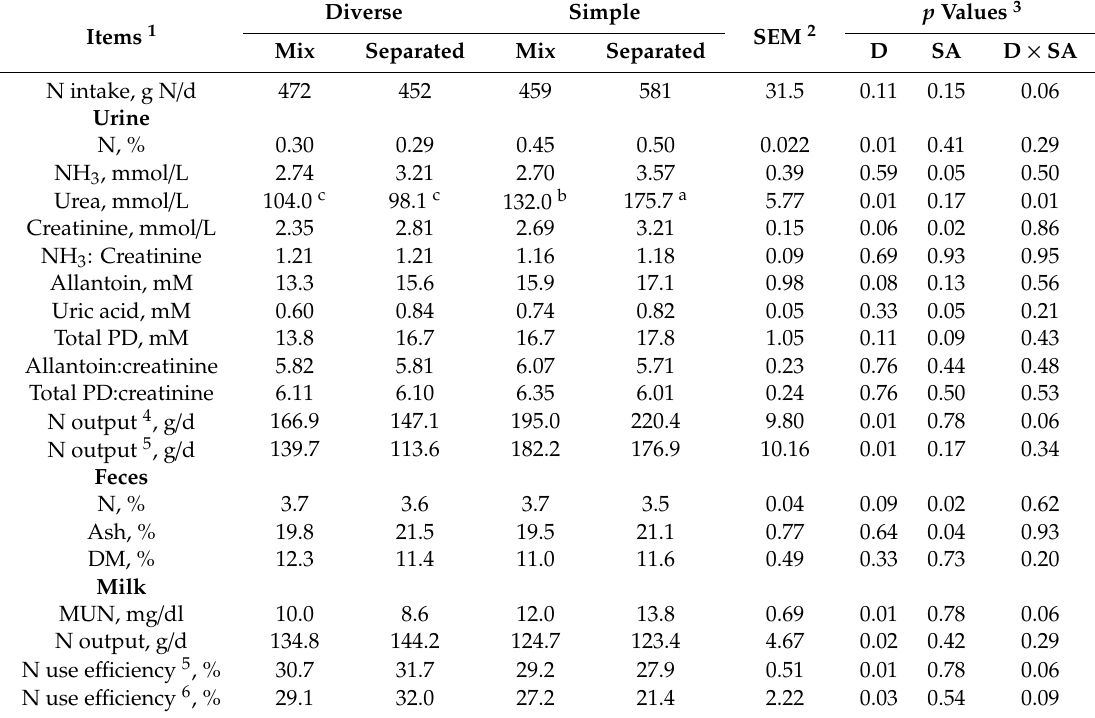
Table 6. E ff ect of pasture diversity (diverse or simple) and spatial arrangement (mix or separated) on nitrogen partitioning in dairy